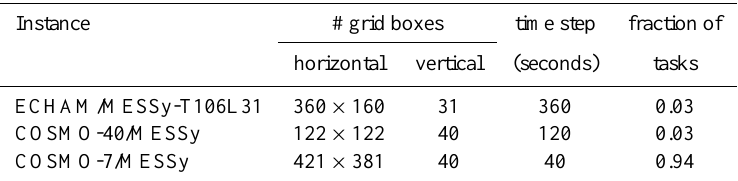
Table 1. Fraction of MPI tasks for the different MECO(2) instances estimated for a maximum efficiency from the number of grid boxes and time step